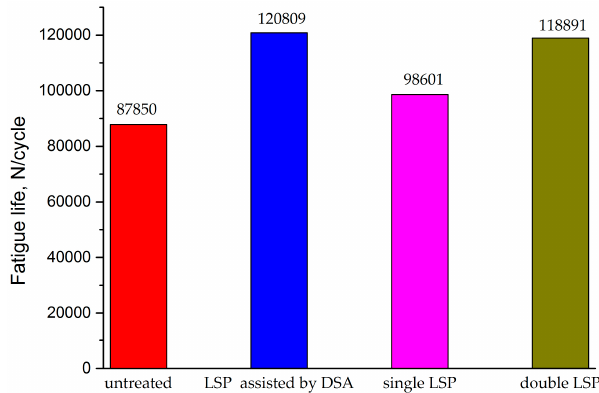
Figure 5. Fatigue life of specimens subjected to different LSP processes.